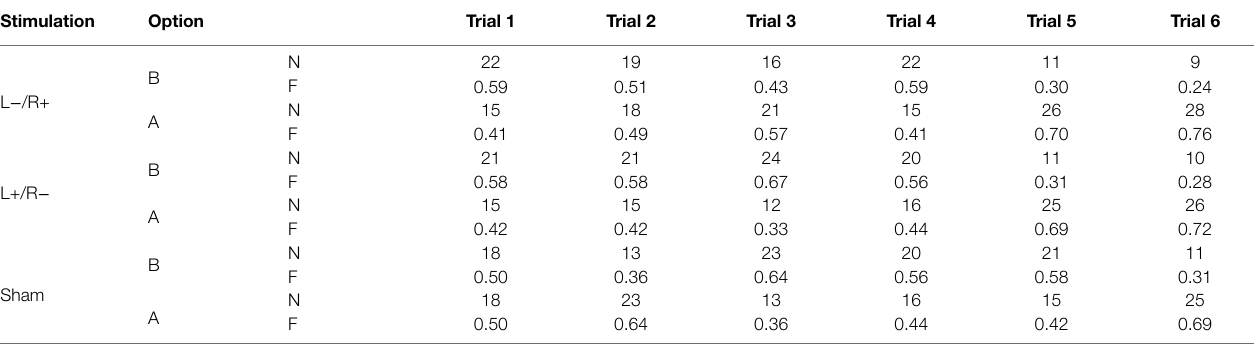
TABLE 5 | Number (N) and frequency (F) of chosen option dataset under three conditions. Stimulation Option Trial